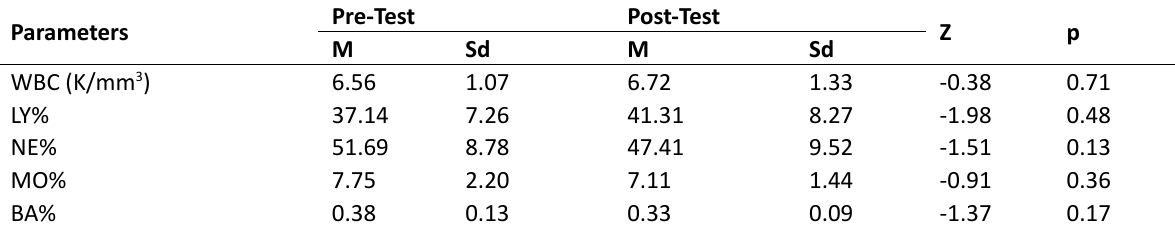
Table 3. Comparison of for the pre- and post-tests results in leukocyte parameters